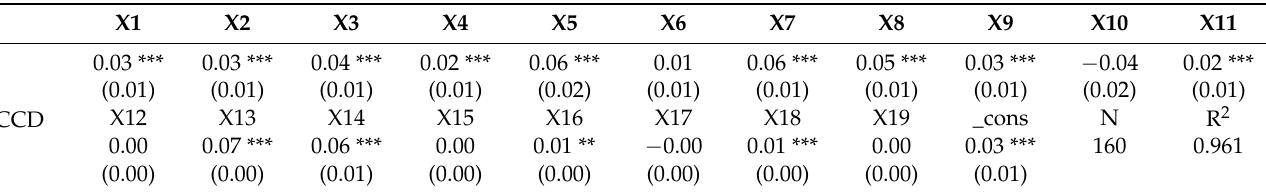
Table 6. Regression analysis